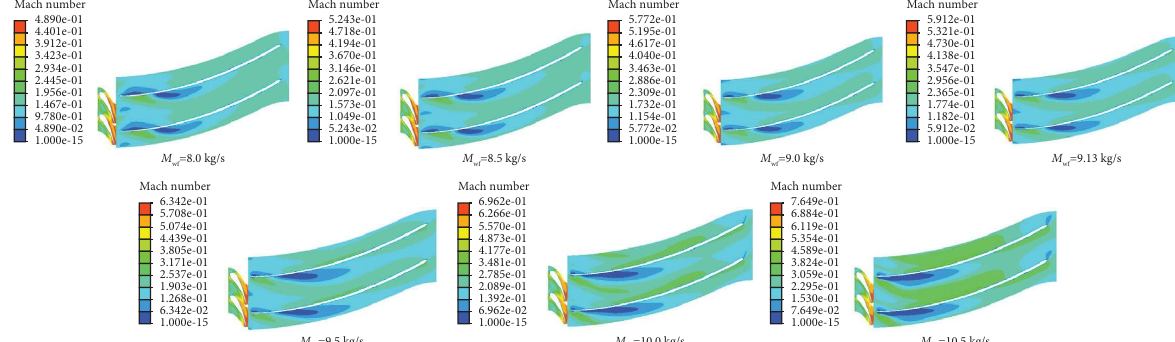
Figure 15: Distribution of Mach number at the half blade height with mass fow rate.